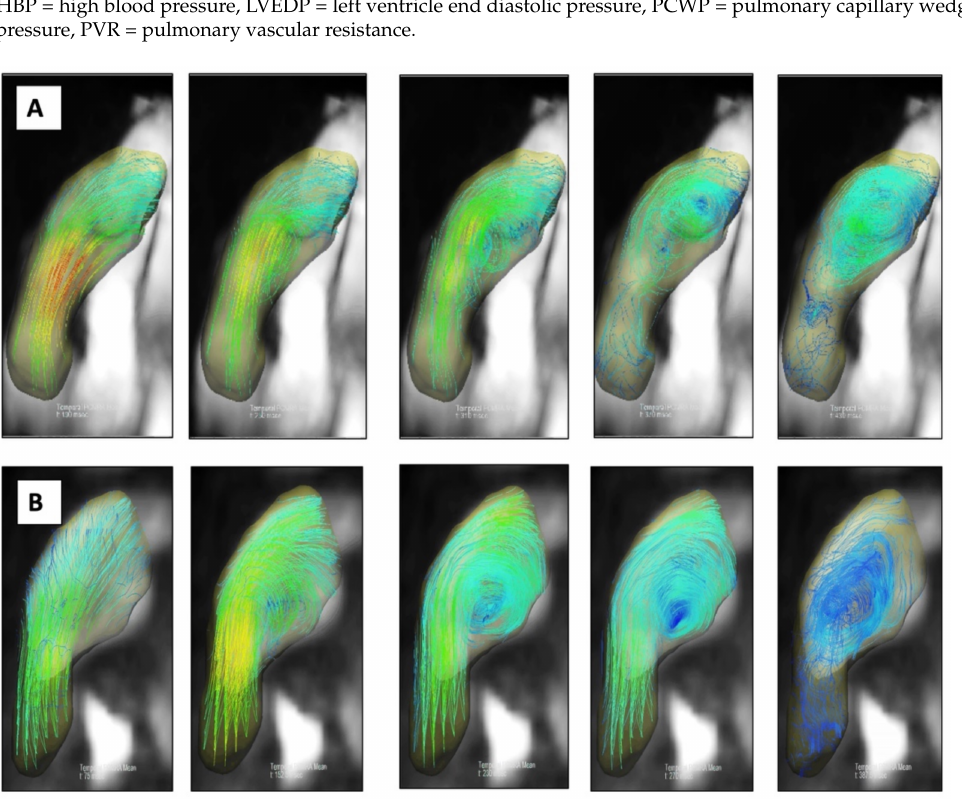
Figure 2. Examples of two patients with CTEPH, PH and vortical flow on 4D flow MR images. Patient 1 (( A ) first image row) exhibited a vortical flow within pulmonary artery, detected during 60% of the cardiac cycle. Mean PAP was 46 mmHg by RHC. Patient 2 (( B ) second image row) exhibited a vortical flow within pulmonary artery, detected during 32% of the cardiac cycle. Mean PAP was 26 mmHg by